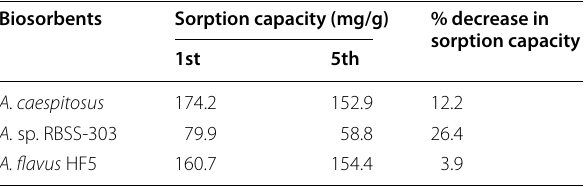
Table 6 Percentage decrease in Pb(II) sorption